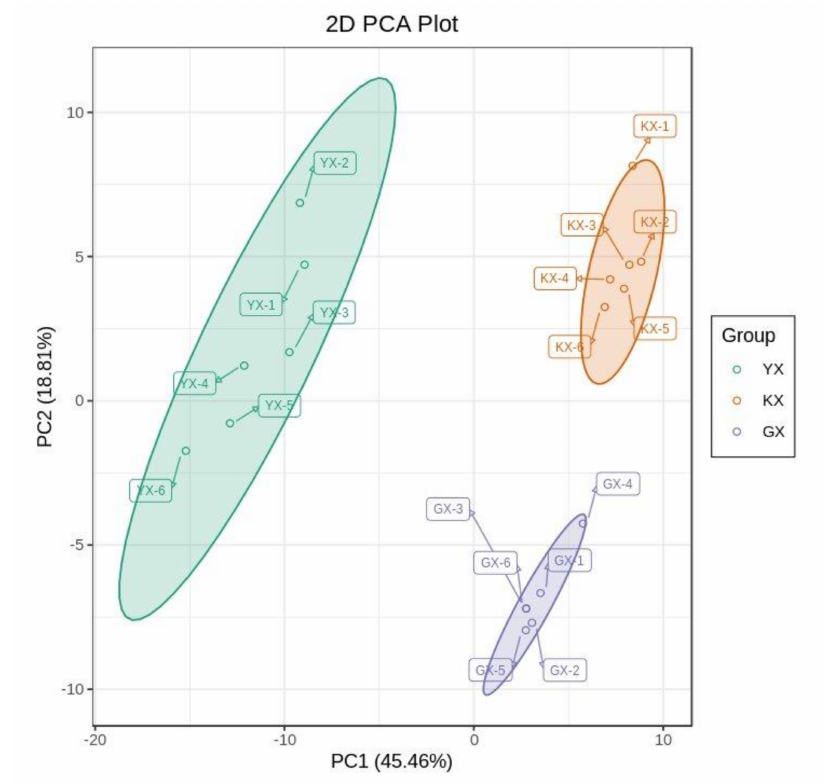
Figure 3. Principal components (PC) analysis of mass spectrum data of three cucumber cultivars YX, KX, and GX.